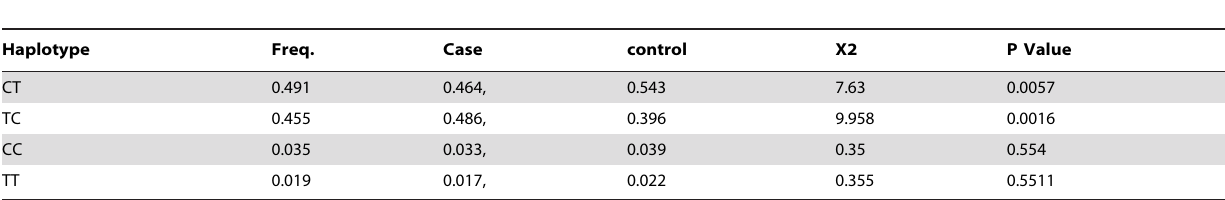
Table 4. The distribution of haplotype embracing the two loci, 2 31 and 2 511 in the promoter of IL-1 b .